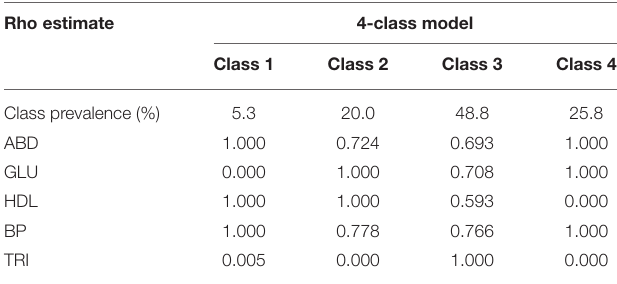
TABLE 4 | Conditional probabilities of meeting criteria within latent metabolic syndrome 4-class model of participants with metabolic syndrome in 2014. Rho